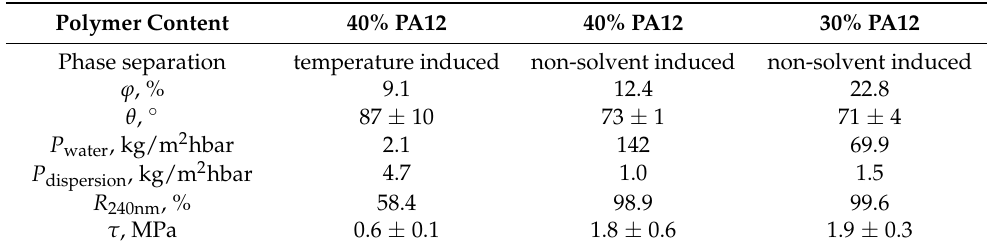
Table 1. Porosity, wettability, permeability, microfiltration ability, and tensile strength of the porous films from polylaurolactam. Polymer Content 40% PA12 40% PA12 30% PA12 Phase separation temperature induced non-solvent induced non-solvent